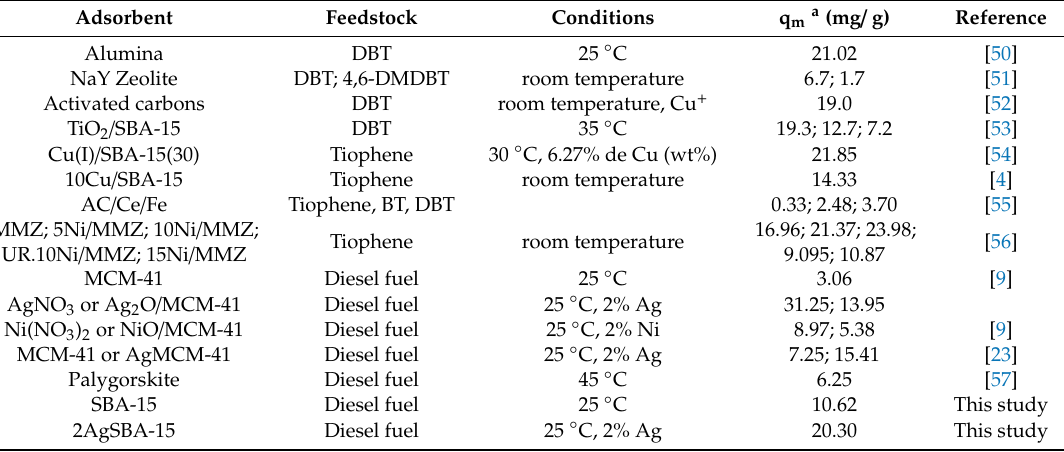
Table 4. Comparison of sulfur adsorption performance data for some materials studied in literature.